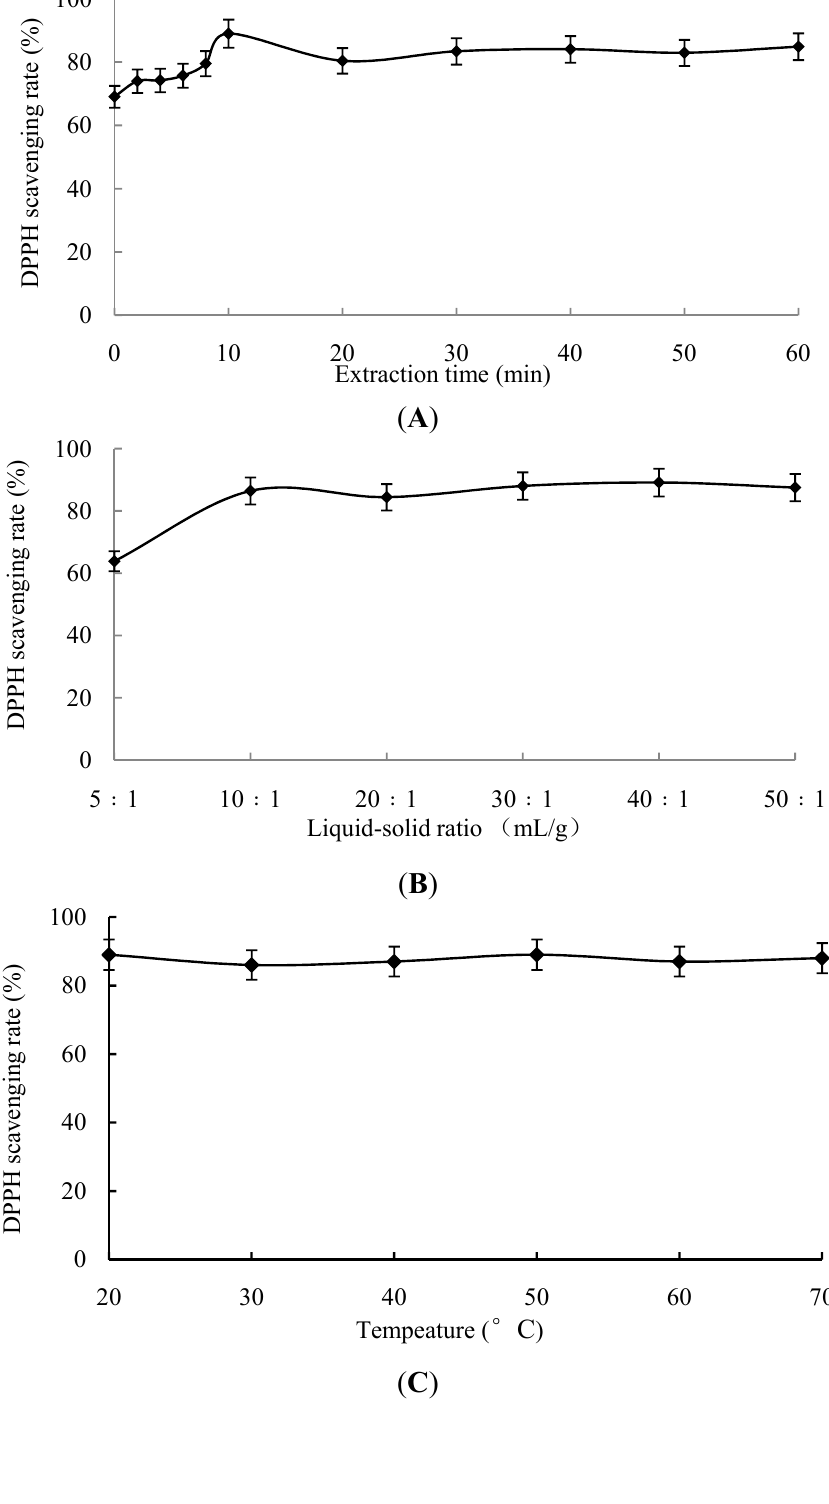
Figure 1. The influence of ( A ) extraction time; ( B ) Liquid-solid ratio; ( C ) Extraction temperature; ( D ) pH of extraction solvent and ( E ) Ethanol concentration on antioxidant activities of